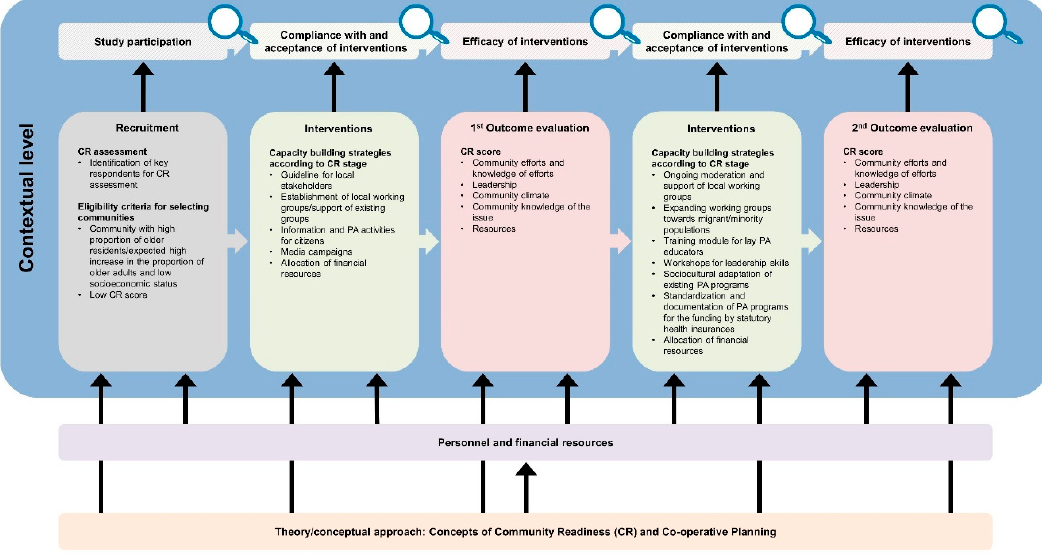
Figure 5. Specific equity-focused logic model for the contextual-level intervention to increase community readiness (CR) to engage older adults in physical activity (PA) interventions implemented in RTC.